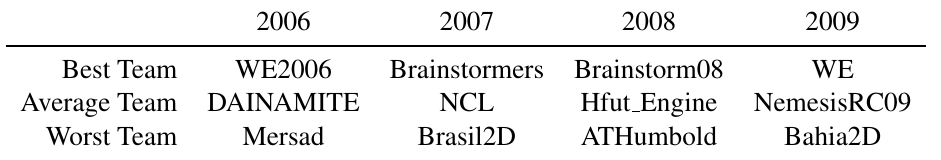
Table 3: RoboCup 2D final competition table illustrating the best, average and worst